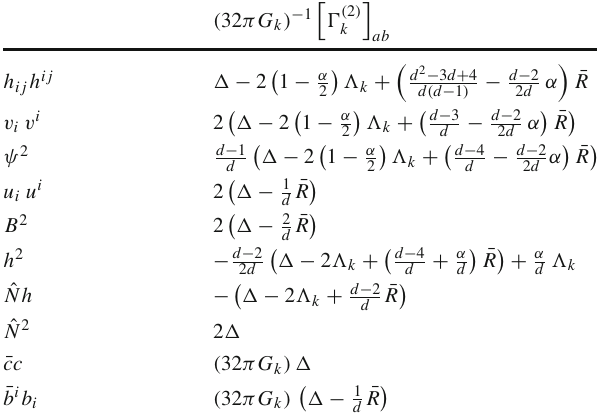
Table 4 List of non-zero matrix elements appearing in the Hessian (cid:2) ( 2 ) . The gravitational sector is obtained from the combination (B.26) k while the ghost contributions given in the last two lines arise from (20). Each off-diagonal entry is accompanied by a suitable entry with the order of the fields reversed (cid:17) (cid:18) (cid:2) ( 2 ) ( 32 π G ) − 1 k k